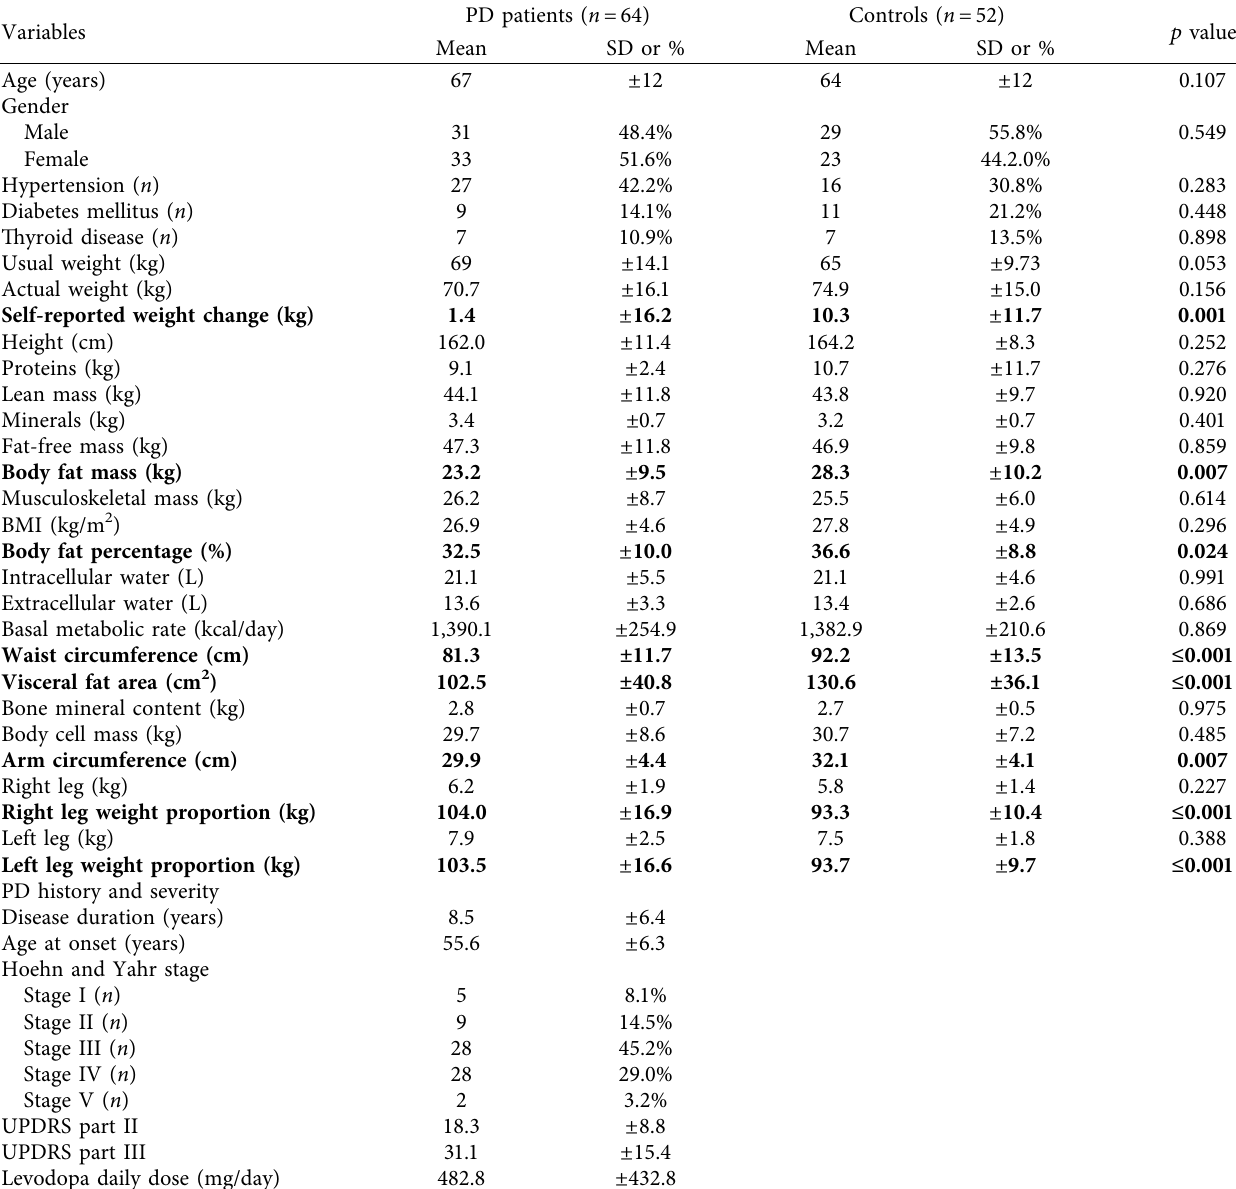
Table 1: Demographic and BIA parameters of PD patients and control